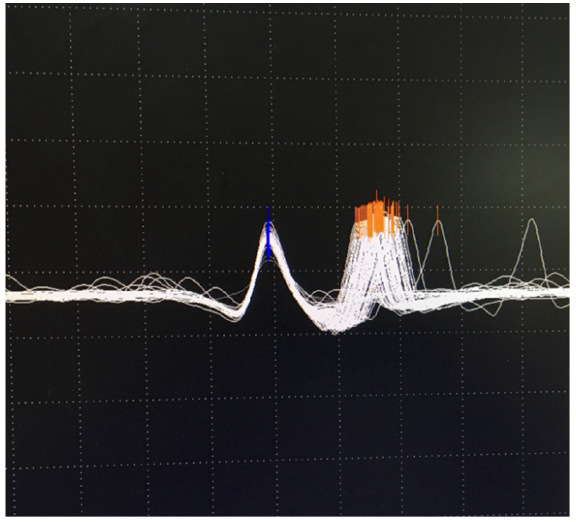
Figure 9. Superimposed traces: abnormal jitter with blocking. Grid 0.1 mV by 0.3 msec.